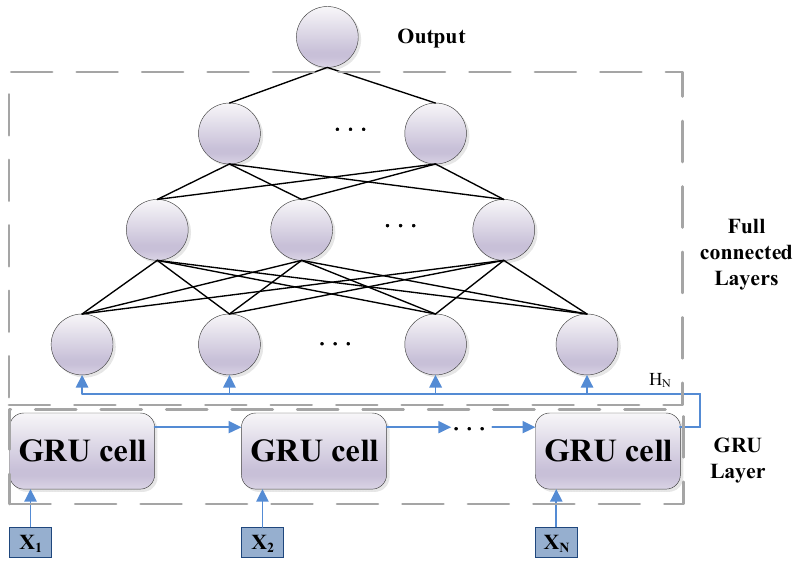
Figure 5. Structure of the GRU sub-model.